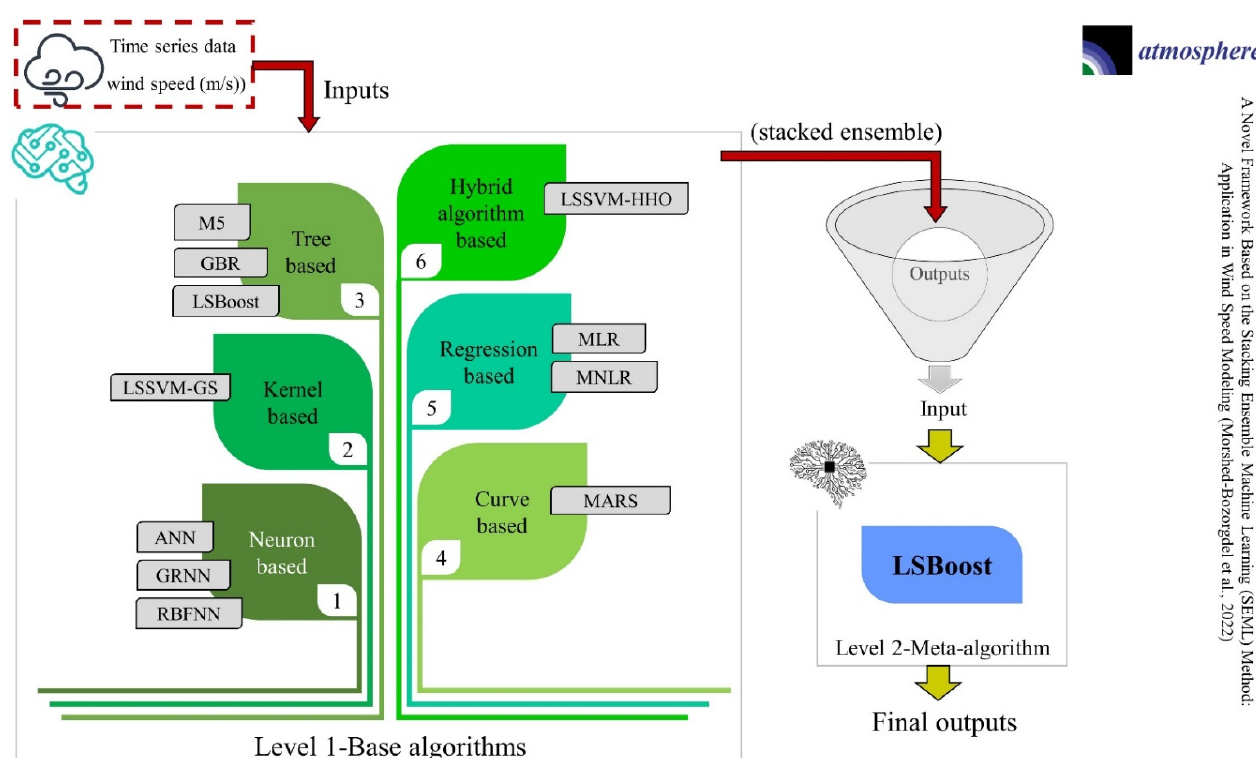
Figure 1. Flow chart of the novel framework based on the SEML method for WS modeling.